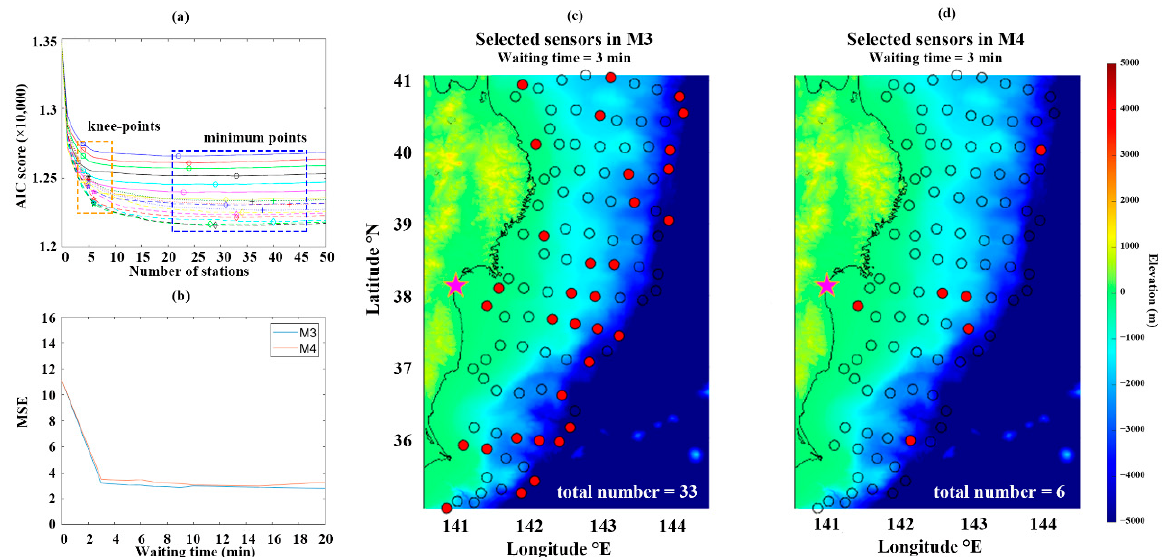
Figure 13. Results of the risk-based early warning model for Iwanuma: ( a ) AIC score plot, ( b ) MSE- waiting time plot, ( c ) optimal sensor map for M3, and ( d ) optimal sensor map for M4. The pink star represents the target location (Iwanuma). The red and empty circles represent the selected and unselected sensors, respectively.